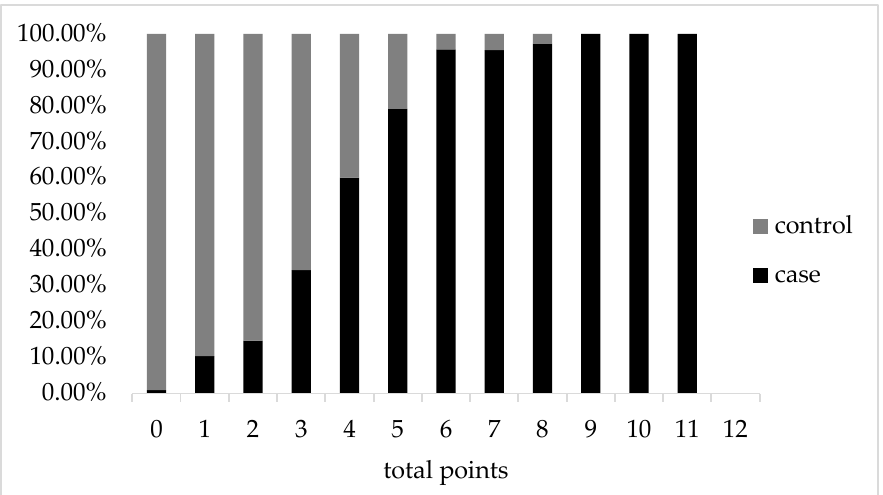
Figure 3. Composition of each hazard score in the modeled population. (cid:4) represents the composition ratio of patients in the case group at this score, and represents the composition ratio of the control group at the same score. The total score was 12 points.